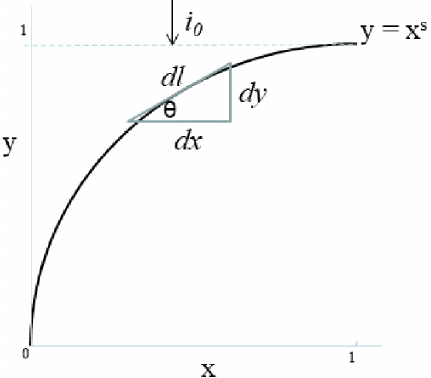
Figure 5. Schematic to aid in the estimation of sediment shortwave insolation for an axially symmetric lake with a given shape factor s <